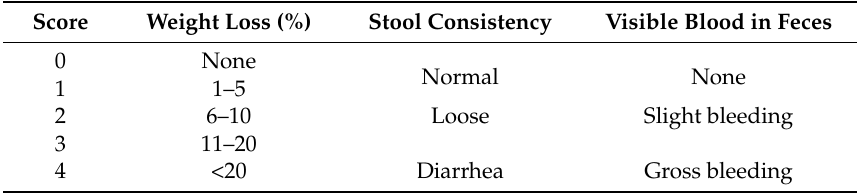
Table 1. Scoring system to calculate the disease activity index (DAI *).